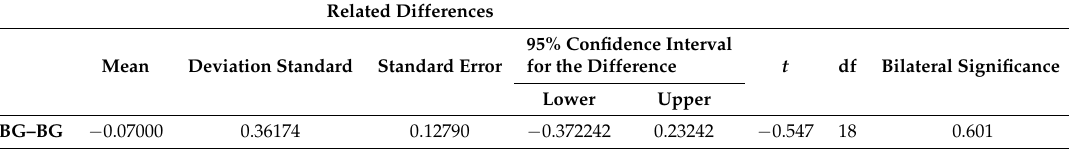
Table 9. Result of the Student’s t -test for the NBG–BG